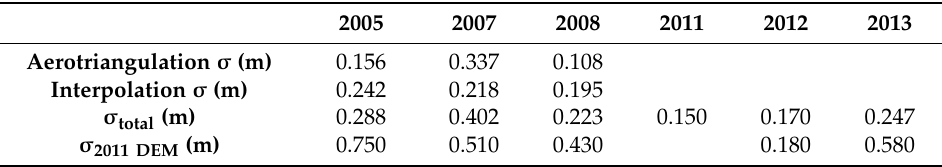
Table 3. Accuracy evaluation of datasets obtained from different periods.